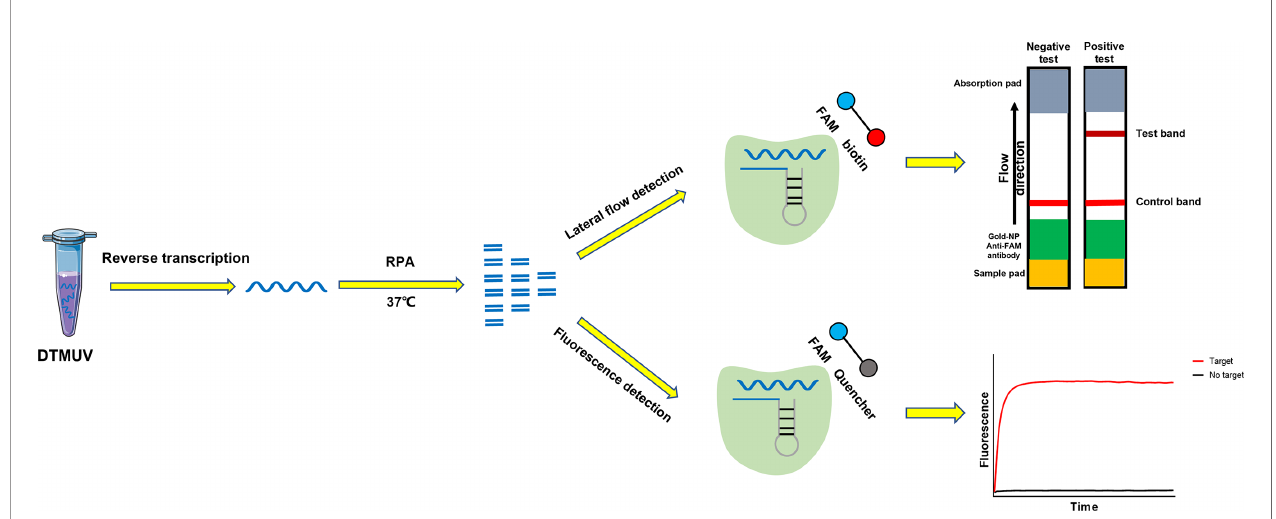
FIGURE 1 | Schematic illustration of the work fl ow for Cas13a DTMUV